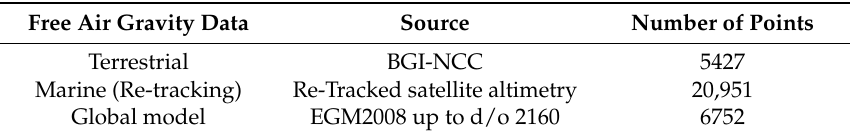
Table 1. The summary of the input gravity data.